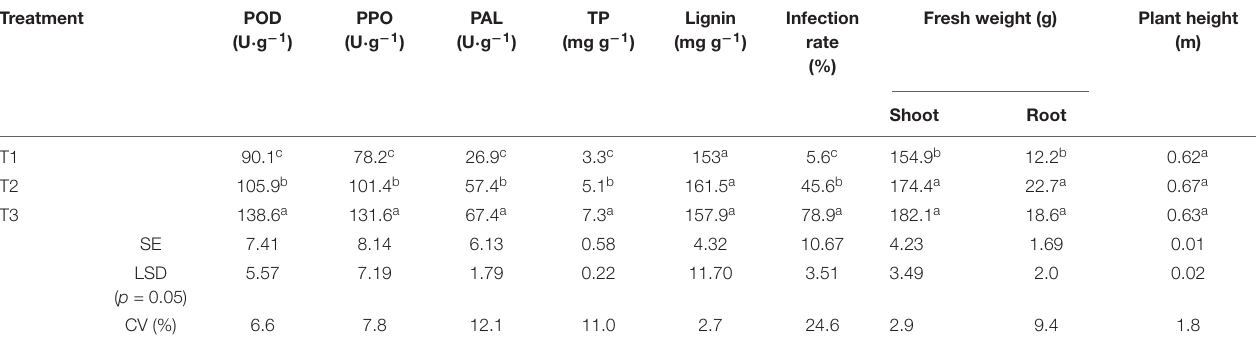
TABLE 2 | Comparison of defensive enzyme activities, active substances and susceptibility rates of plant disease resistance in different treatments in greenhouse experiments.